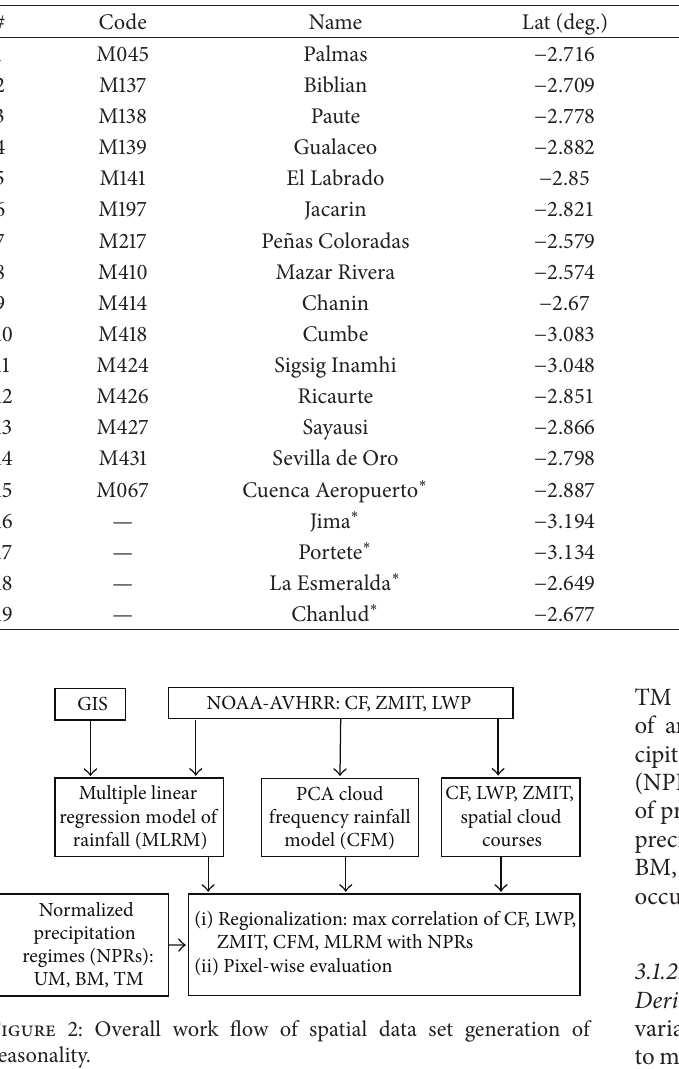
Table1:PrecipitationstationsofthePauteriverbasin.INAMHI(InstitutoNacionaldeMeteorolog´ıaeHidrolog´ıa)stationswithdailydataand ETAPA (Empresa P´ublica Municipal de Tel´efonos, Agua Potable y Alcantarillado de Cuenca) with hourly data. ∗ Stations used for validation